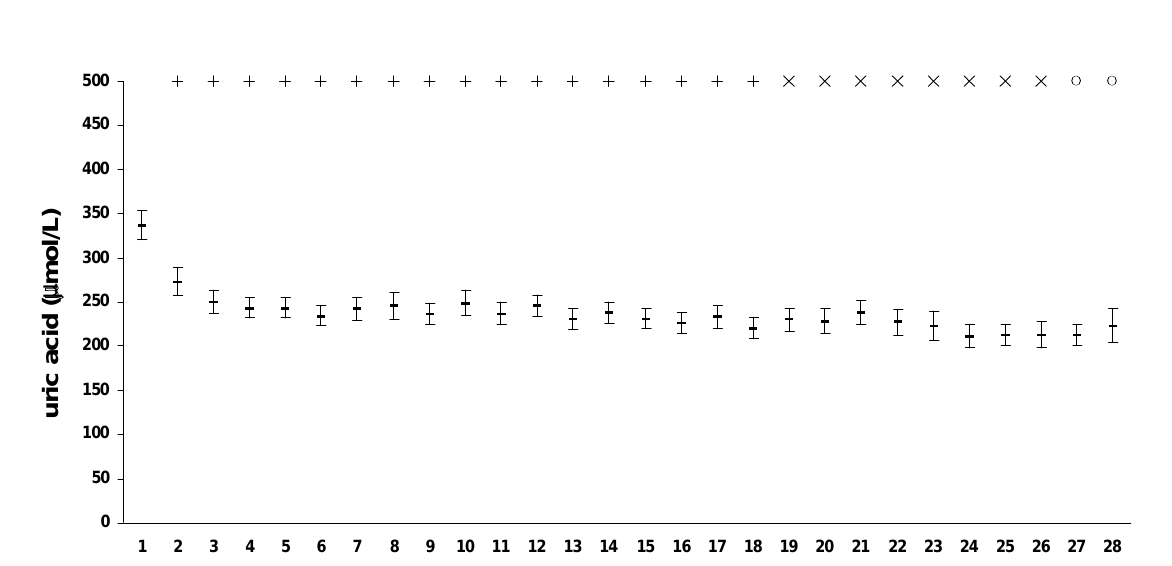
Figure 1.: Serum uric acid concentrations during the course of therapy. Shown is the mean (with standard error of the mean indicated by the error bars) of serum uric acid concentrations at baseline (visit 1) and on subsequent visits in approximately weekly intervals. + p < 0.00001; × p < 0.0001; (cid:129) p < 0.01 compared to